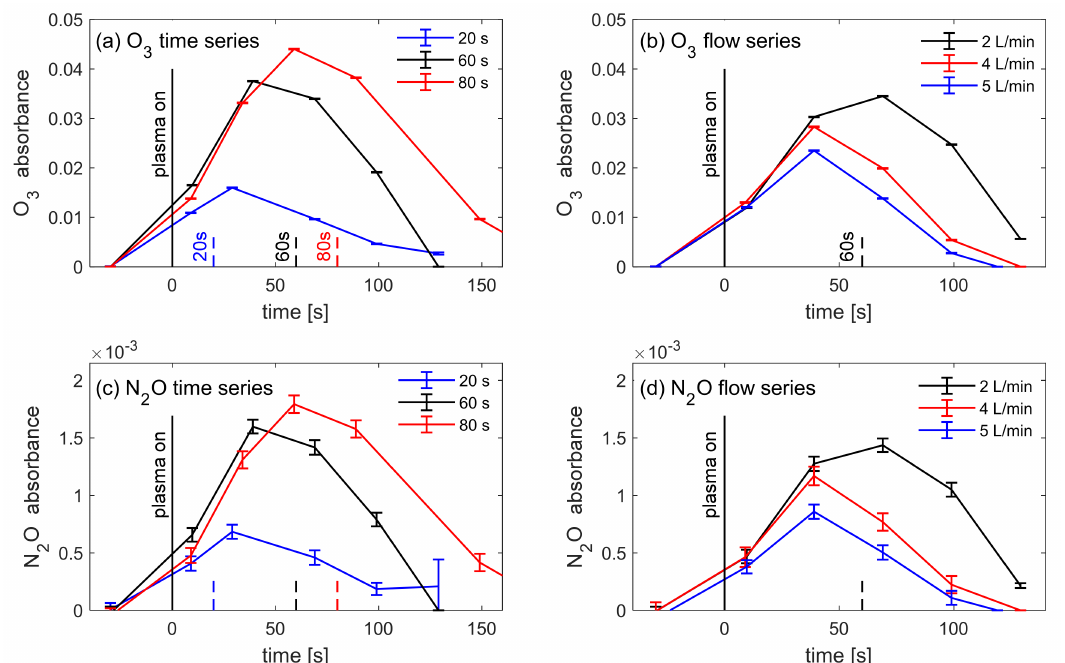
Figure 3. Time-dependent absorbance measurements of O 3 and N 2 O from the series of treatment times (20, 60, and 80 s plasma duration) and flow rate (2, 4, and 5 L/min). The densities of both molecules increase with the plasma treatment time, and decrease with the air flow rate, as expected. The O 3 and N 2 O molecules follow similar trends for each series. The measurements for the default parameters are shown in